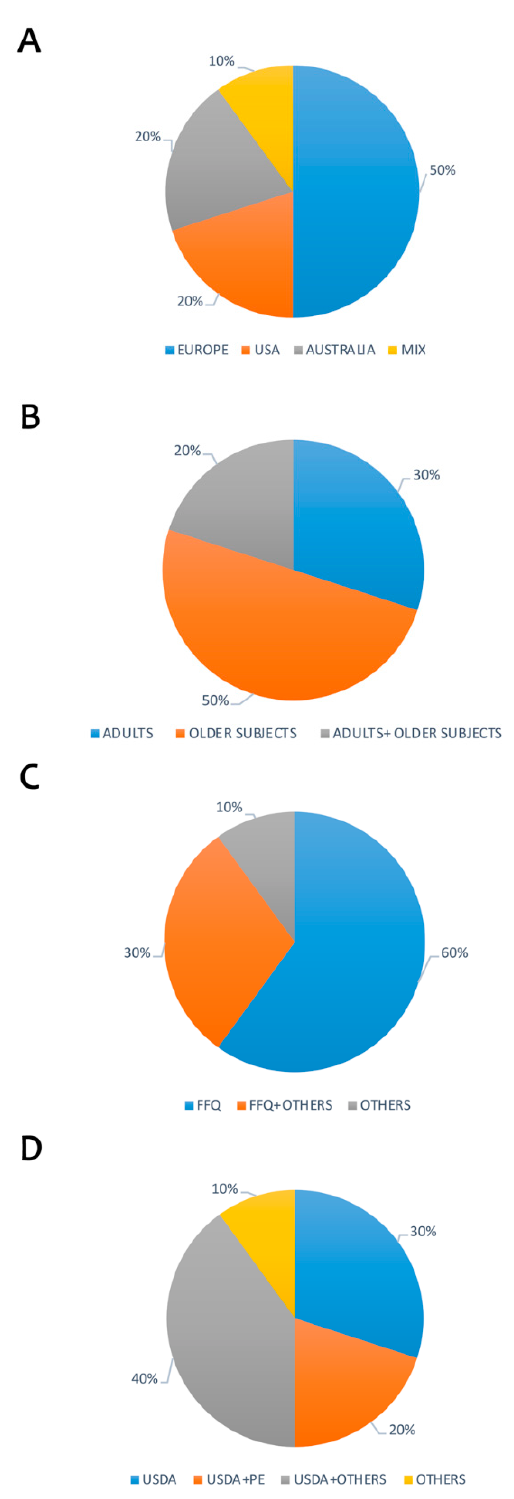
Figure 5. Estimation of polyphenols intake, all-cause and cardiovascular mortality risk. Legend: ( A ) Distribution of published data by country; ( B ) Target population considered; ( C ) Questionnaires used to evaluate food intake; ( D ) Polyphenol database used for evaluation of intake. FFQ: Food Frequency Questionnaire; USDA: United States Department of Agriculture; PE: Phenol- Explorer.